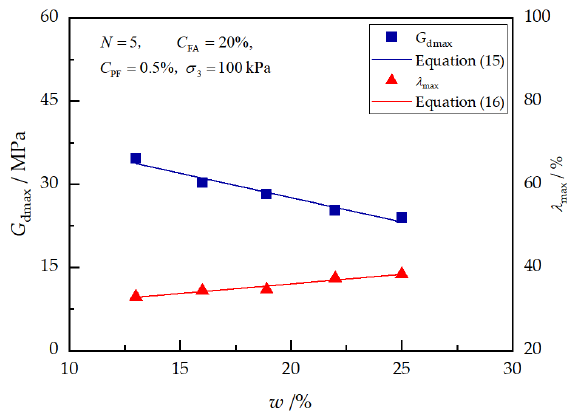
G and λ . max dmax